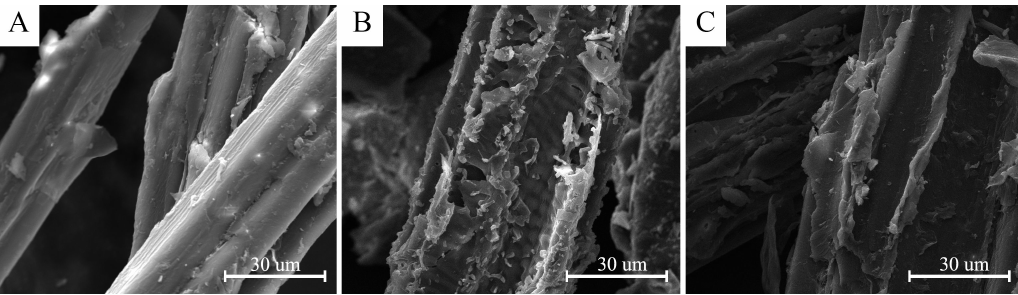
Figure 4. Scanning electron microscope (SEM) images of BF ( A ), MAH-e-BF ( B ), and LA-e-BF ( C